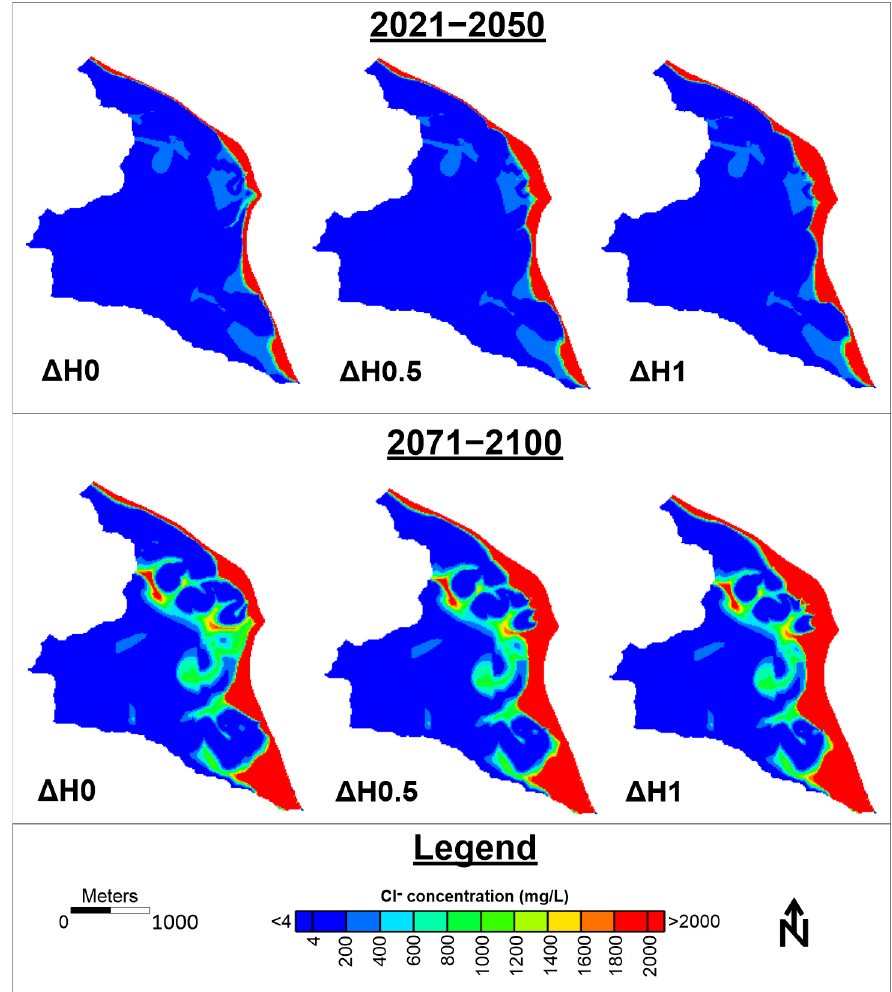
Figure 9. Spatial distribution of groundwater Cl − concentration at the end of periods 2021–2050 and 2071–2100 for no sea level rise ( Δ H0), sea level rise of 0.5 m ( ΔΗ 0.5) and sea level rise of 1 m ( ΔΗ 1).